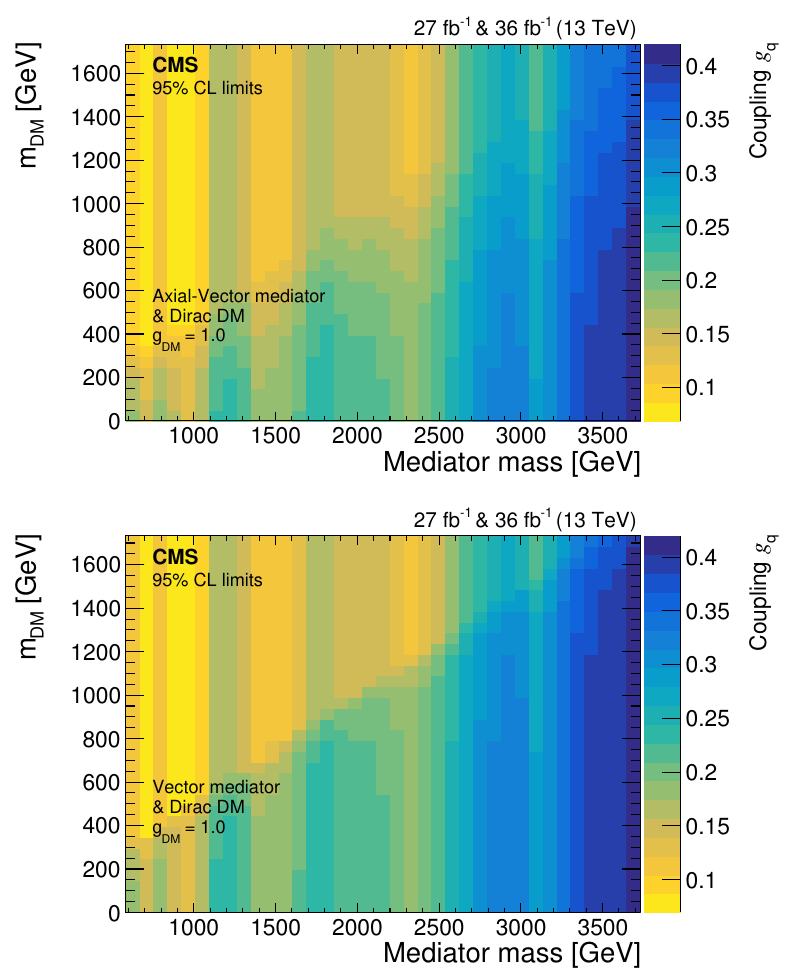
Figure 15 . The 95% CL observed upper limits on a universal quark coupling g q (color scale at right) in the plane of the dark matter particle mass versus mediator mass for an axial-vector mediator (upper) and a vector mediator (lower).